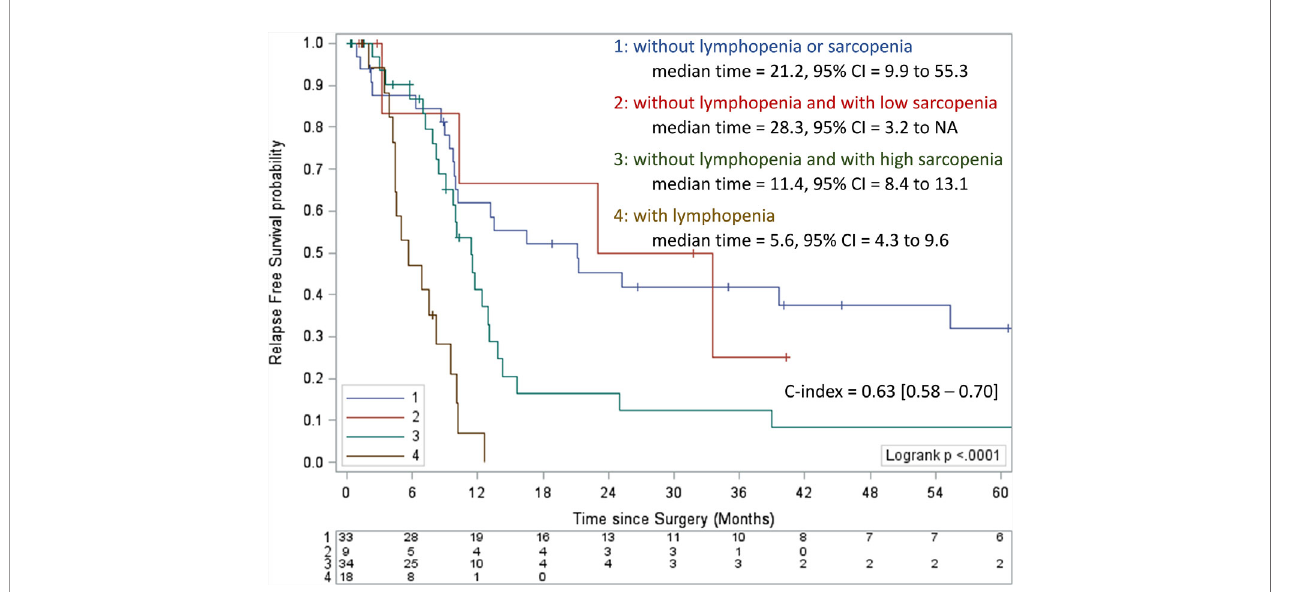
FIGURE 4 | Kaplan-Meier curves of relapse-free survival according to preoperative lymphopenia and the level of sarcopenia. Values of the log-rank test P <0.05 were considered statistically signi fi cant, and all tests were two-sided. CI, con fi dence interval; NA, not